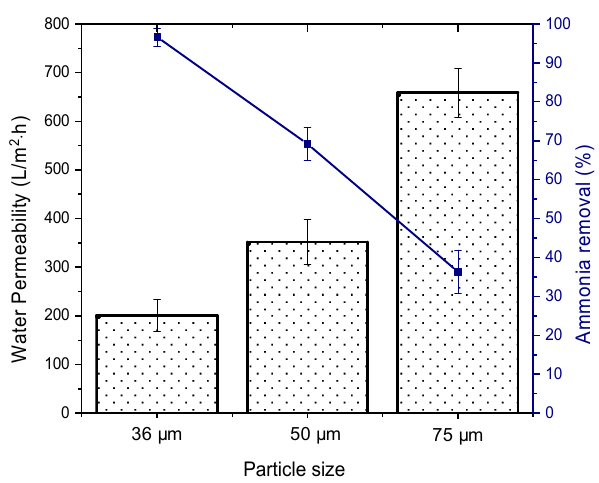
Figure 10. The ammonia removal and water permeability of the adsorptive HFCM derived from di ff erent particle size (n = 3).